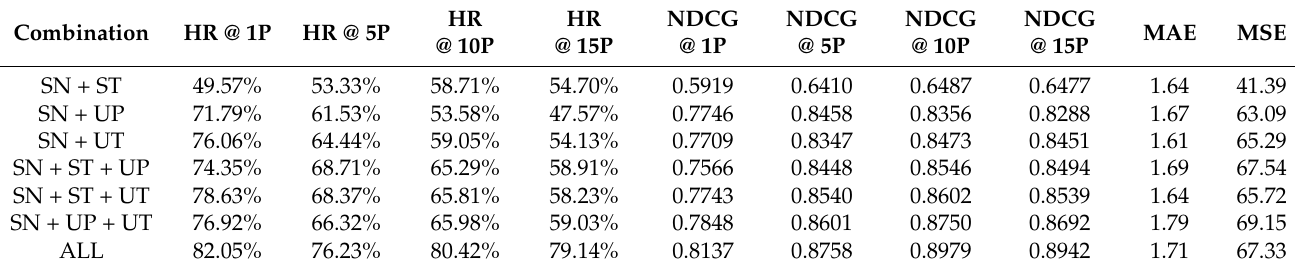
Table 5. The performance comparison for fake news popularity